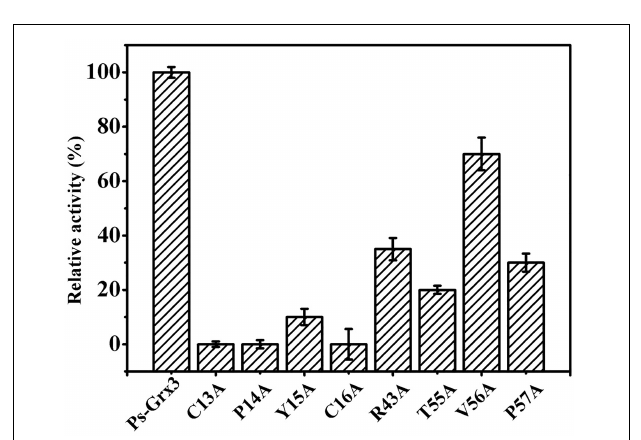
FIGURE 4 | Measurement of the relative activity of Ps-Grx3 mutant forms generated by site-directed mutagenesis. The activity of the enzyme without mutation was defined as 100%. The experiments were carried out three